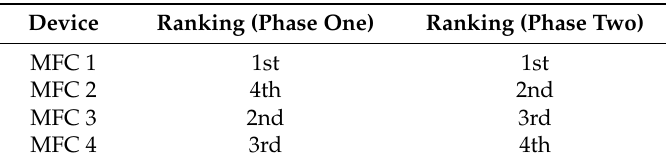
Figure 8. MFC power ranking waveform. Table 3. MFC power rank.